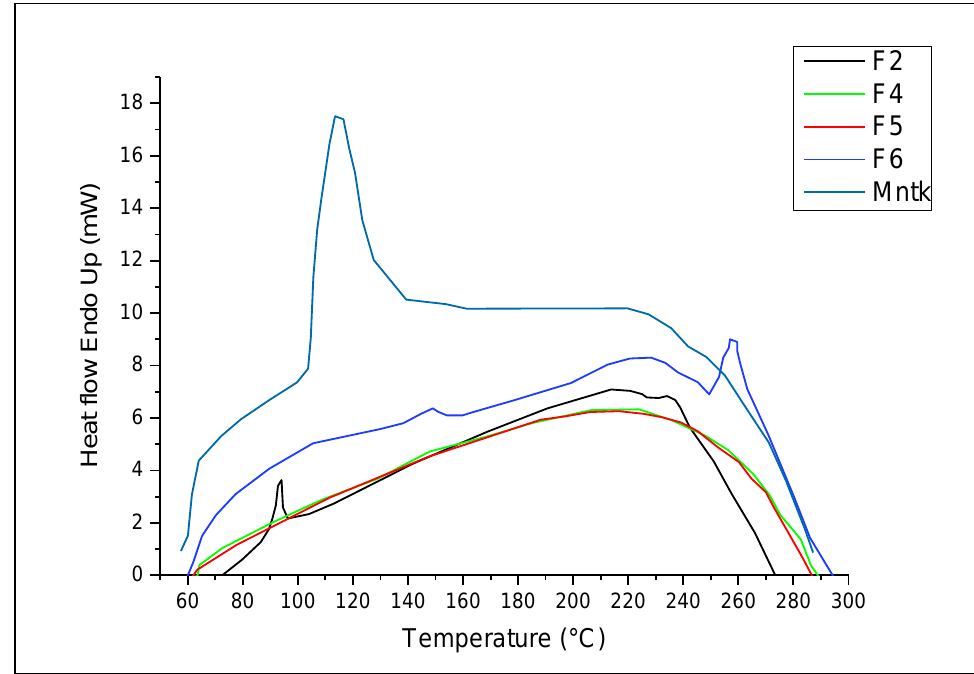
Figure 5. DSC analysis of pure drug and selected nanoparticles (F2 – F4)